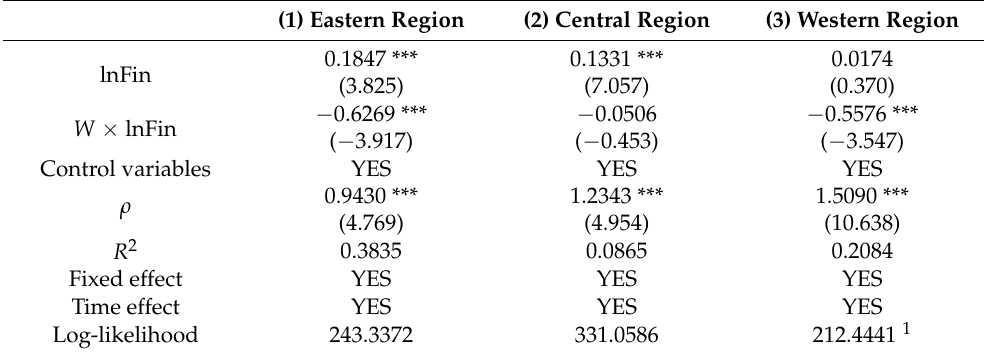
Table 11. The results of regional heterogeneity